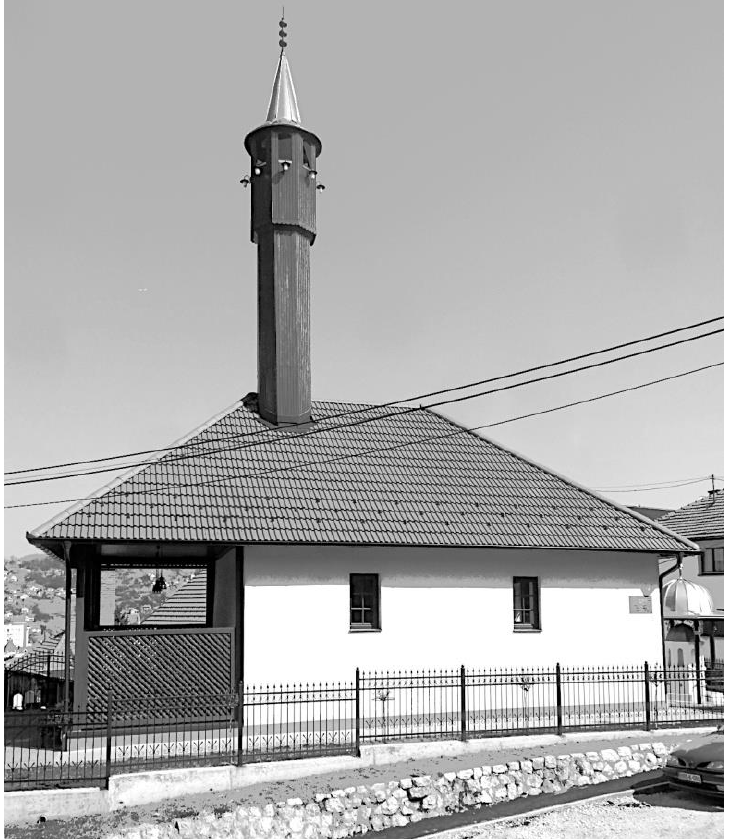
Figure 5. Osman Ćehaja Mosque after the renovation (Photo by the